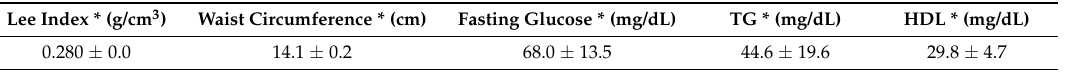
Table 2. Normal values for parameters used for obesity and MetS diagnosis in Wistar